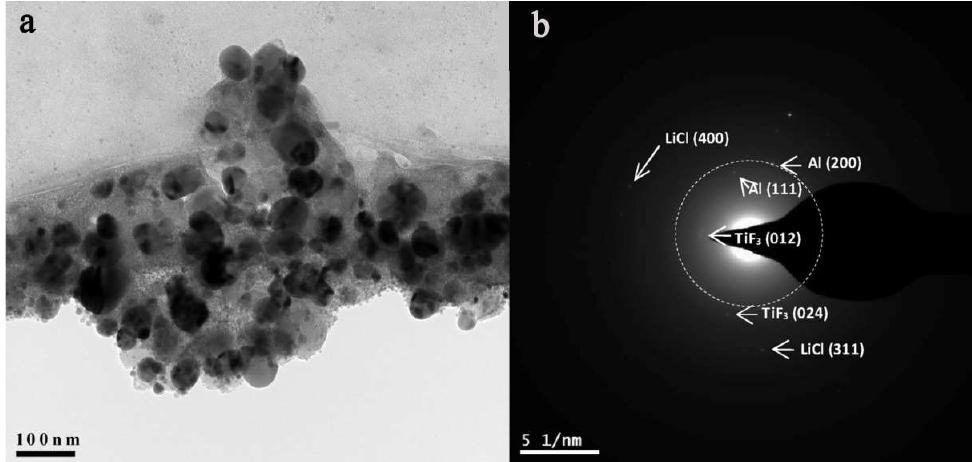
Figure 13. TEM image of α-AlH 3 /LiCl-TiF 3 after dehydrogenation for 600 s at 160 °C (bright field TEM, ( a ); ED pattern, ( b )). Reprinted/adapted with permission from Ref. [203]. 2019, Elsevier B.V.